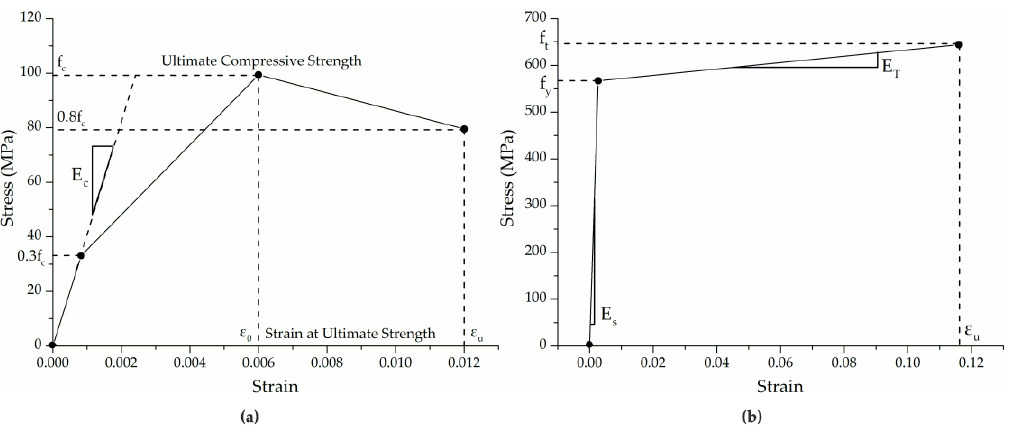
Figure 5. Uniaxial stress-strain curves for ( a ) compressive concrete; ( b ) tensile steel bar.